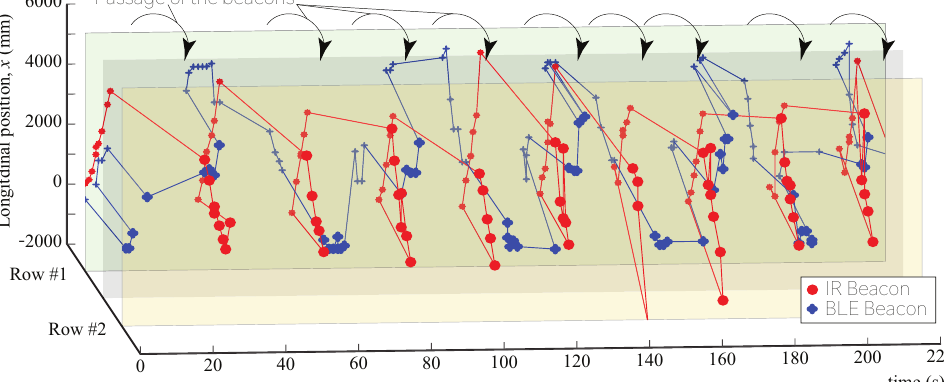
Figure 7. Three-dimensional plot of positioning results. The red line represents the IR beacon, and the blue line represents the BLE beacon. The transverse axis of the graph represents the passage of time; the longitudinal axis represents the depth of the passage (position described as x in Figure 4); moreover, the depth axis represents the two passages (transverse axis in Figure 4). While the IR beacon is able to track movement for 10 laps by moving back and forth between two paths, the BLE beacon failed to track the movement